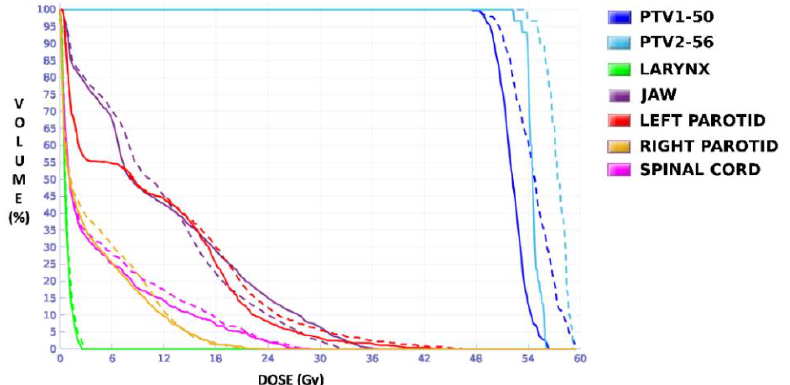
Figure 6. DVHs of the planning solutions for Case 1 under EARL1 (dashed lines) and EARL2 (solid lines) accreditations on the volumes generated with EARL2.